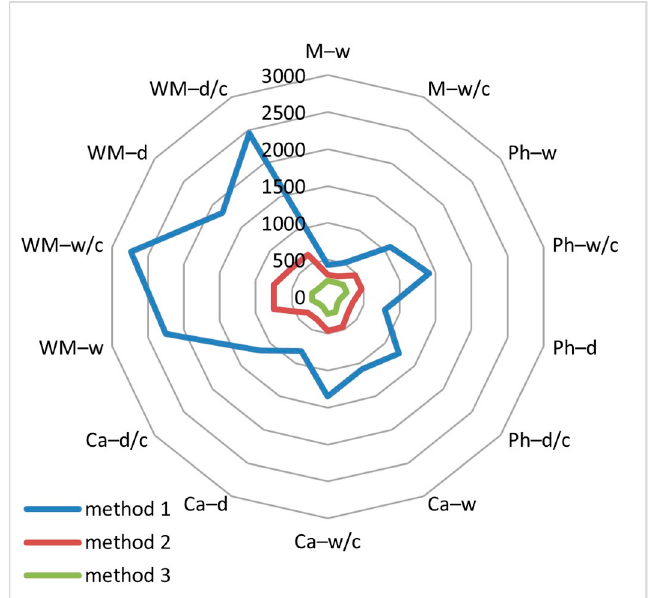
Figure 10. Differences in the assessment of greenhouse gas emissions (g CO 2 eq. kWh el. − 1 ) related to anaerobic digestion depending on the calculation method. Method 1—all steps included in bioenergy